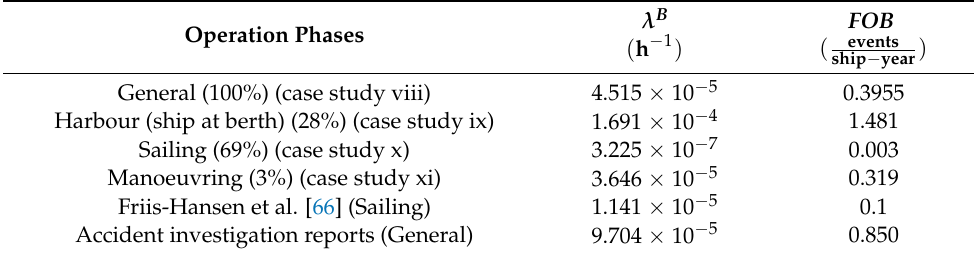
Table 6. Comparison of λ B in different operation